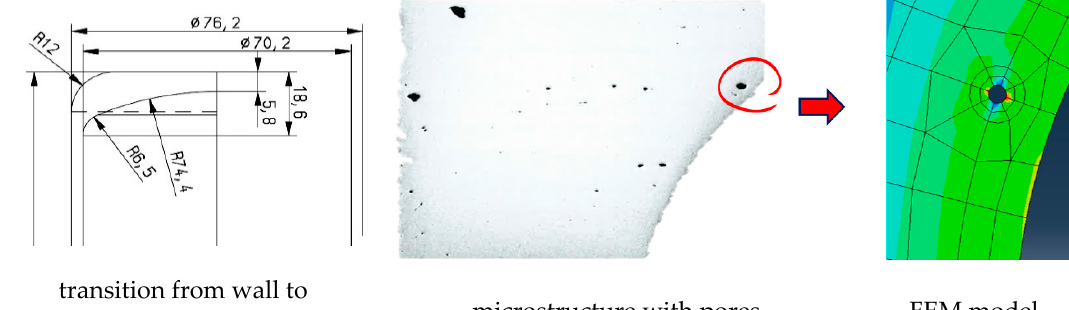
Figure 5. Pore simulation based on computer tomography results [20].